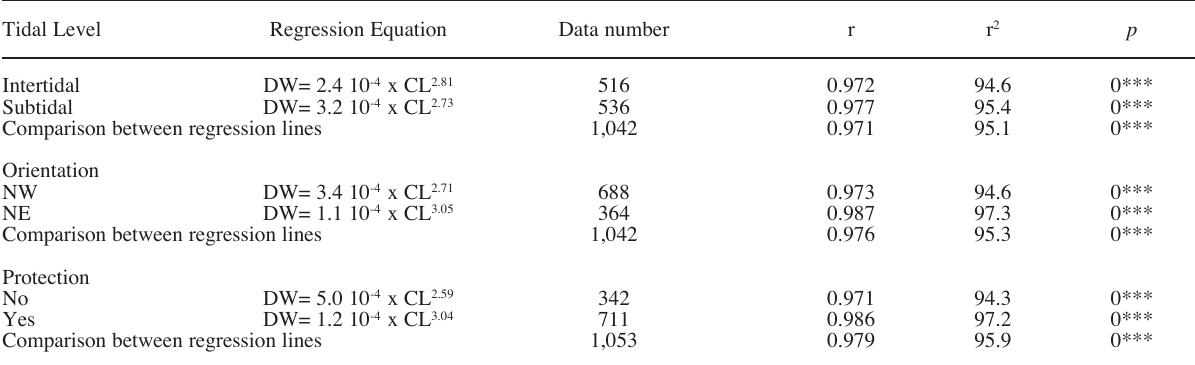
T ABLE 4. – Allometric relationships between capitulum length (CL) and dry weight (DW), depending on the tidal level, orientation and pro- tection in the locations. The comparison between regression lines was made after log-transforming data sets. Key: r=correlation; r 2 =